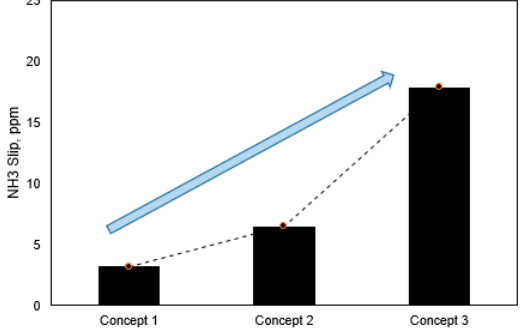
Figure 5. NH 3 slip results during NRTC with different SCR size.